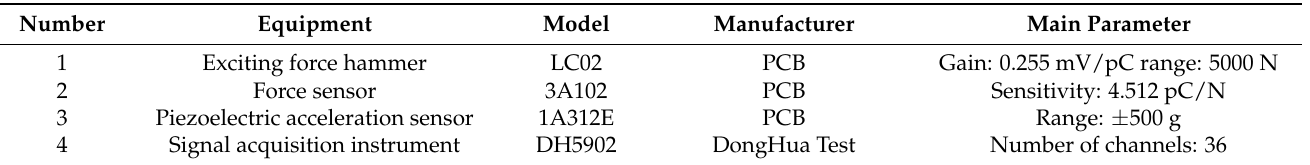
Table 1. Equipment and the parameters required for modal test.